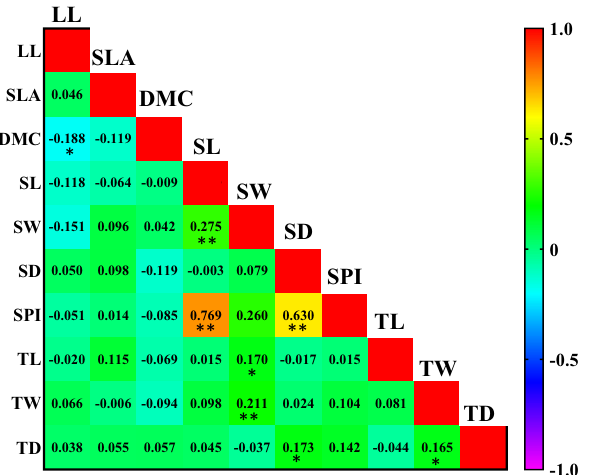
Figure 6. Pearson’s correlation coefficients between leaf morphological and anatomical traits of Quercus brantii in semi-arid climate. Orange and yellow represent strong positive correlations. Leaf length, (LL), specific leaf area (SLA), dry matter content (DMC); stomata length (SL), stomata width (SW), stomatal density (SD), stomatal pore index (SPI), trichome length (TL), trichome width (TW) and trichome density (TD). * P < 0.05; ** P <